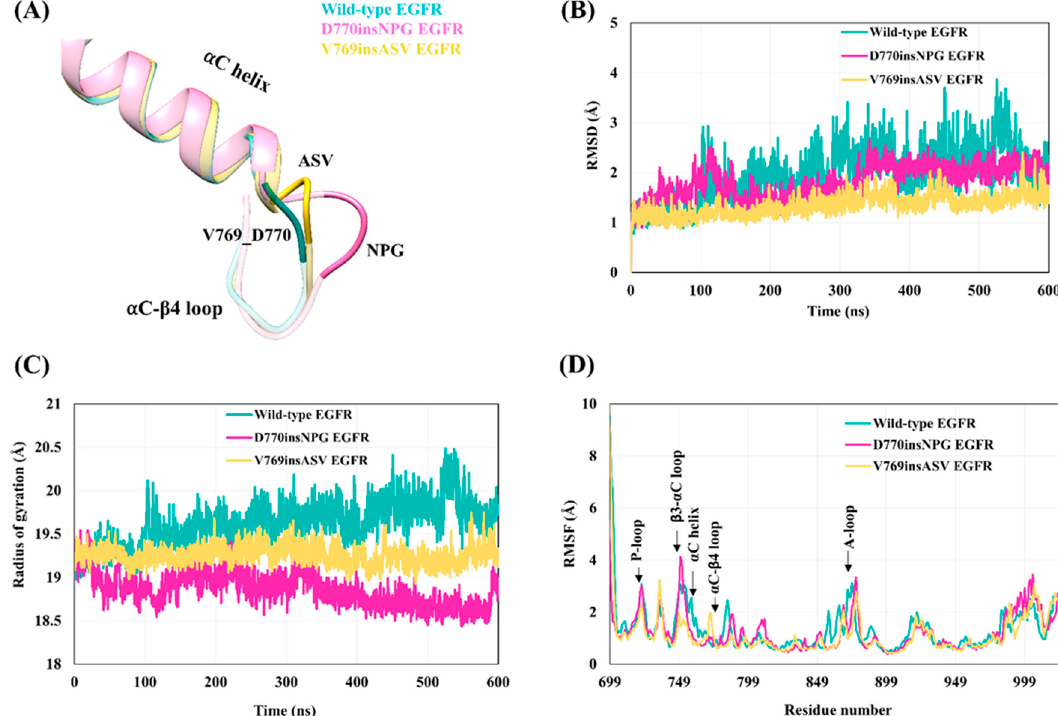
Figure 3. Stability of the wild-type and insertion mutant EGFR kinase domains during the 600 ns molecular dynamics simulation (MDS). ( A ) Starting structure of the wild-type EGFR superposed on the structure of the D770insNPG exon 20 insertion mutant and model structure of the V769insASV exon 20 insertion mutation. The mutations place the additional residues at the C-terminus of the α C helix. ( B – D ) Parameters describing the overall structural variation—i.e., stability—for the wild-type, D770insNPG and V769insASV EGFR kinase domains during MDS: ( B ) backbone-atom root-mean-square deviations (RMSD); ( C ) C α -atom radii of gyration (Rgyr); and ( D ) C α -atom root-mean-square fluctuations (RMSF).